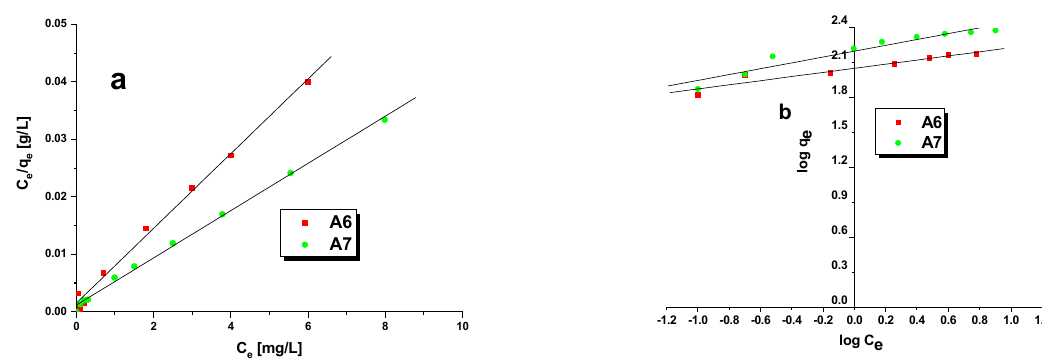
Figure 7. Linear fitting of isotherm models: Langmuir isotherm ( a ) and Freundlich isotherm ( b ).